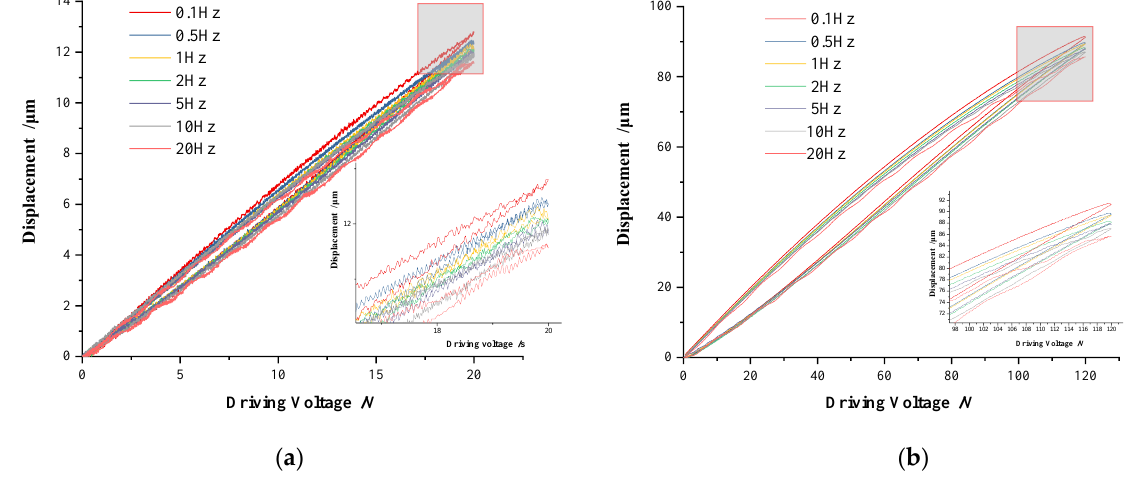
Figure 3. Hysteresis curves on variable voltage frequencies. ( a ) 20 V, ( b ) 120 V.